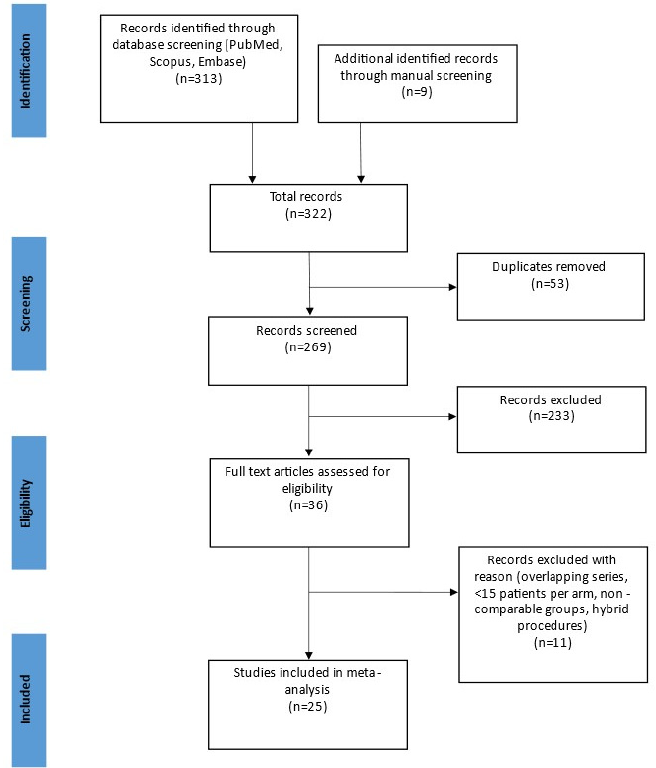
Figure 1. Flow-chart of included articles in accordance with the PRISMA guidelines [37] for systematic reviews and meta-analysis. Of these, 25 articles published between 2007 and 2021 were considered for data ex- traction and were included into this meta-analysis [7,8,10,11,13–28,30–36]. The majority of included trials were of a retrospective study design, 2 prospective studies [30,32] and 1 randomized controlled study [7,11] fulfilled criteria for data extraction. A total of 16099 individual patients who underwent RRC ( n = 1842) or LRC ( n = 14,257) between 2002 and 2020 were identified. Study details and quality assessment of included studies are sum- marized in Table 1. Funnel plots did not show evidence of significant bias among the in- cluded studies. 3.2. Patients’ Characteristics Details of included patients regarding age, sex, BMI, ASA > 2 and number of cancer cases of retrieved studies are shown in Table 2. Patients in the LRC group were signifi- cantly older than in the RRC group (LRC 70.27, ±3.00 vs. RRC 68.79, ±2.90, p = 0.03).